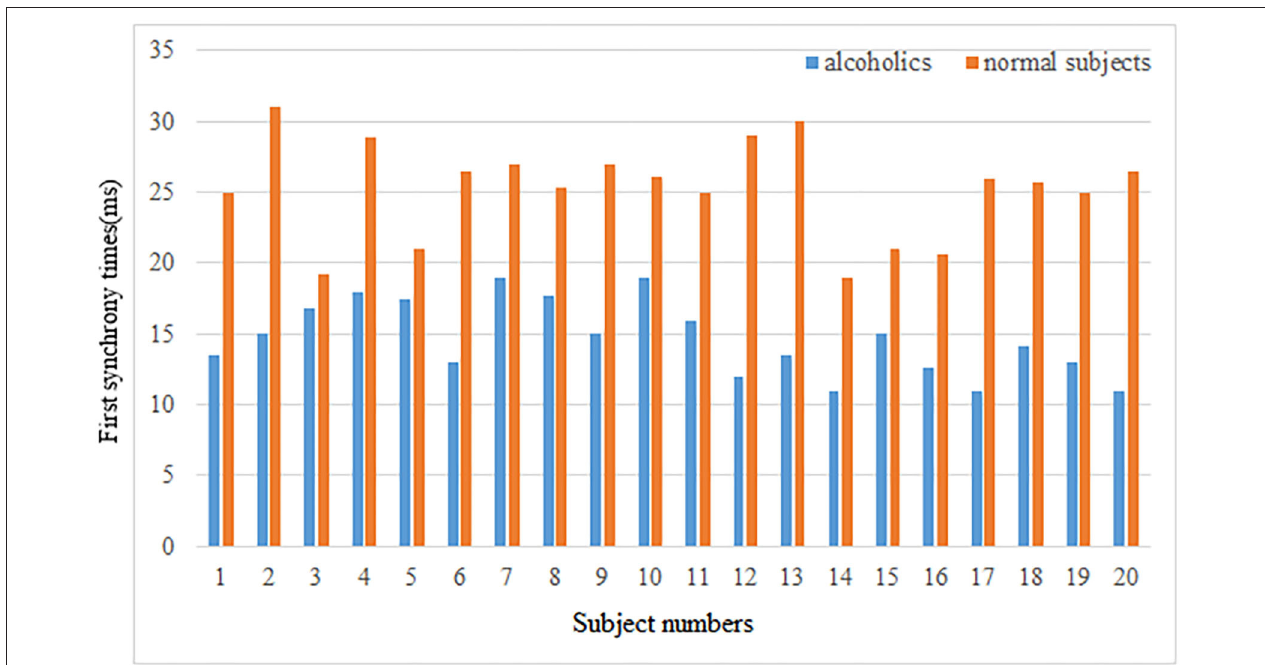
FIGURE 6 | First synchrony